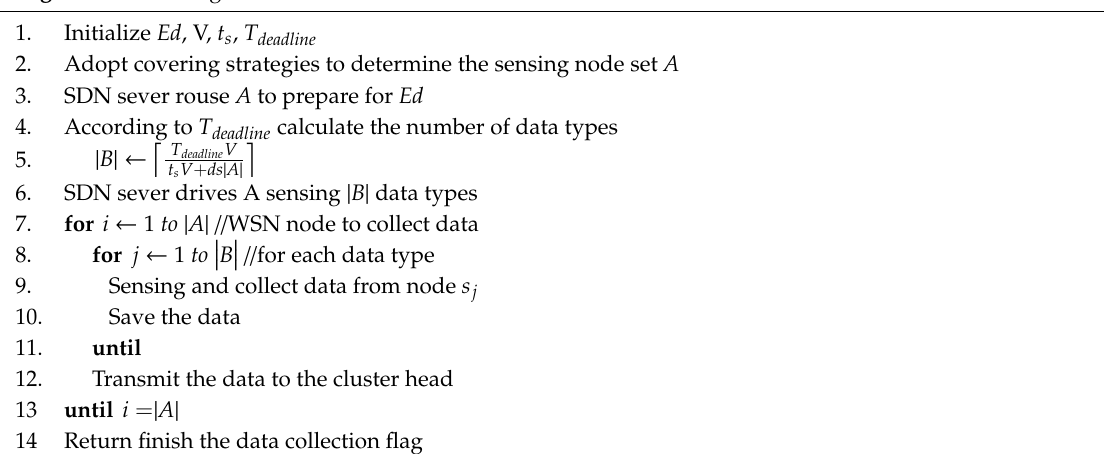
Algorithm 3 Sensing method with time constraints based on